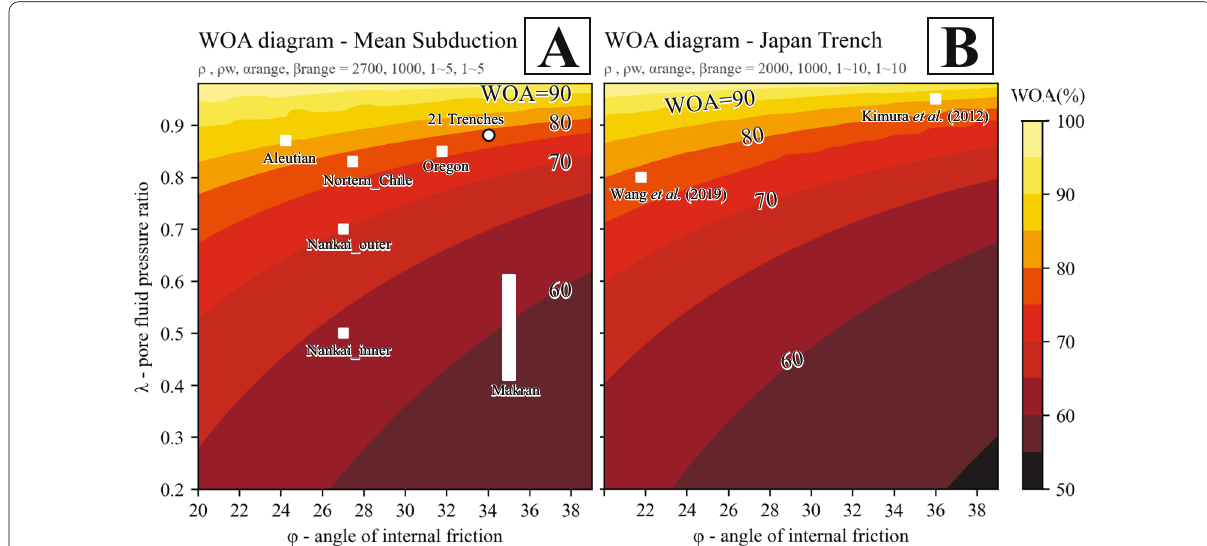
Fig. 4 Diagram of weight of alpha (WOA). The closer WOA is to 100%, the more friction can be considered in terms of seafloor topography alone, because the effective basal friction μ b ’ can be determined from α alone. A WOA diagram of the mean trenches (Lallemand et al. 1994). The white circles indicate the average value of these 21 subduction zones. The white boxes indicate the individual subduction zones, where the values were listed (Wang and Hu 2006). Conditions in the Japan Trench according to Kimura et al. (2012) and Wang et al. (2019) are shown by the two white